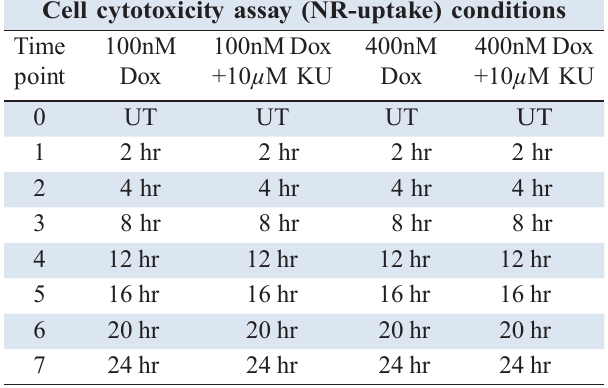
Treatment conditions for NR-uptake based cell cytotoxicity assay.